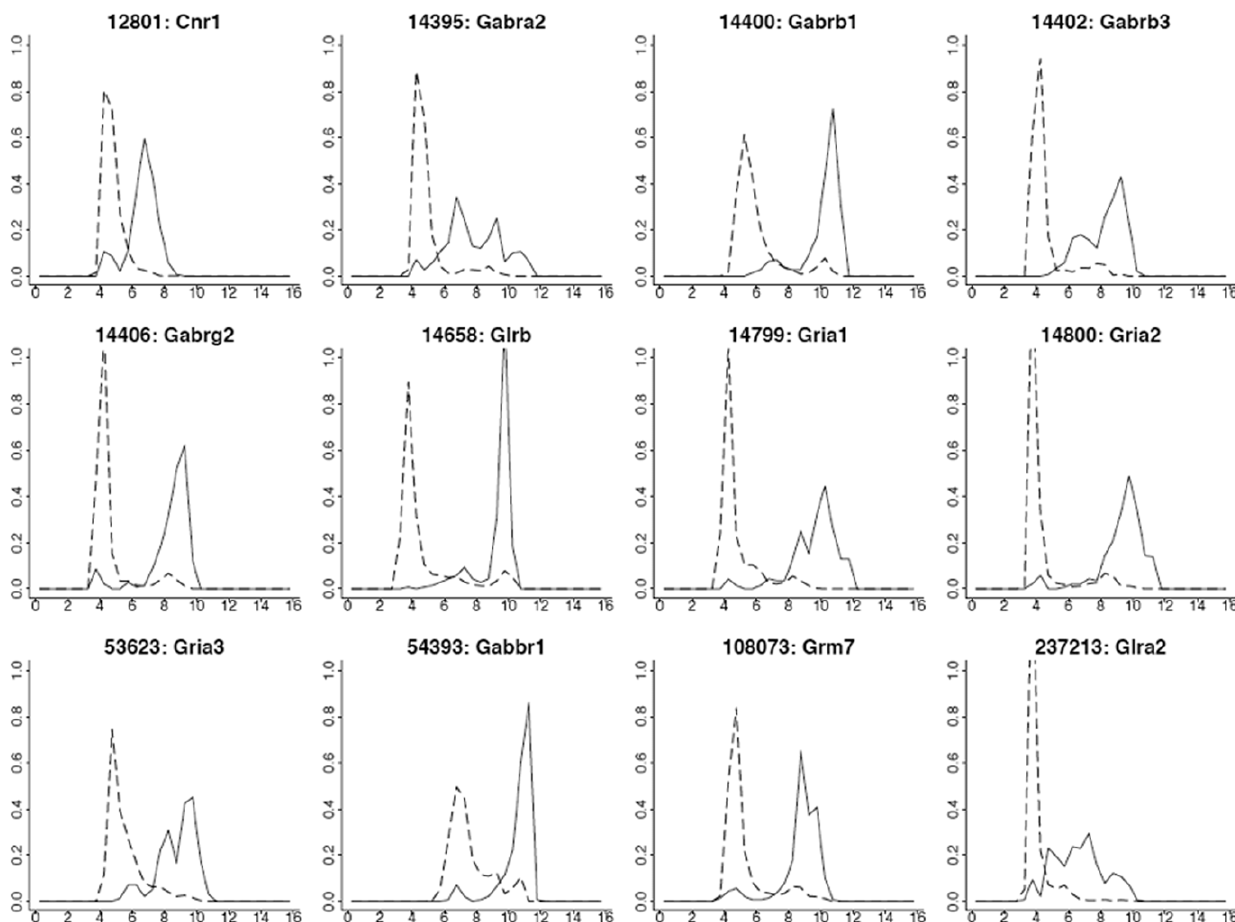
Figure 7. GEPs of the 12 candidate biomarkers from Table 8. Solid lines for brain specific GEPs, dashed lines for non-brain tissue GEPs. Log 2 intensity values appear on the x-axis, probability density appears on the y-axis. doi:10.1371/journal.pone.0009056.g007 Figure S6 Directed acyclic graph of Gene Ontology enrichment for 343 brain biomarker candidates. Table S1 Affymetrix datasets used in this study (as in Jupiter and VanBuren, 2008) *** Note: Refer to .xls source file ***